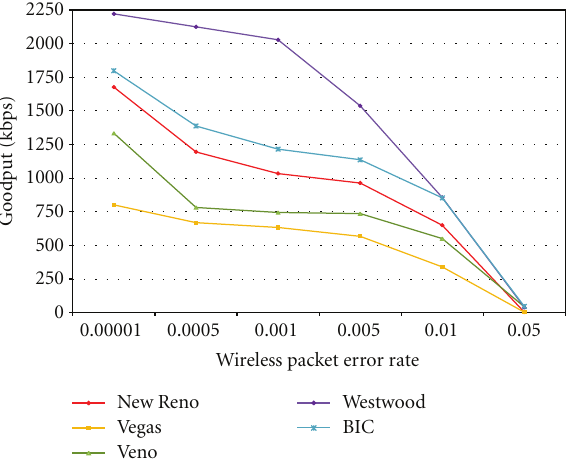
Figure 4: Goodput versus PER in WiMAX for the Scenario